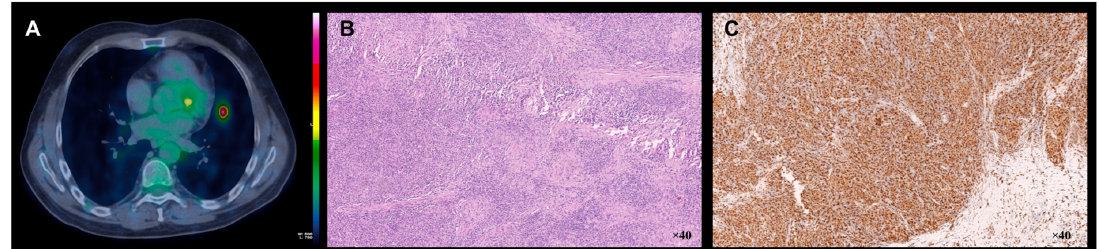
Figure 2. Metabolic and histopathological features of the lung granulomatous lesion. Axial chest 18 F-FDG-PET/CT image ( A ) demonstrating increased metabolism in peribronchovascular nodule localized in the lingular segment of the left lung upper lobe (the units L are the intensity of PET activity, while units W are the intensity of overlap between PET and CT). Lung biopsy: haematoxylin–eosin stain and immunophenotyping showing non-necrotizing granulomatous inflammatory reaction ( B ) with accumulation of Cluster of Differentiation 68 positive (CD68+) macrophages ( C ).